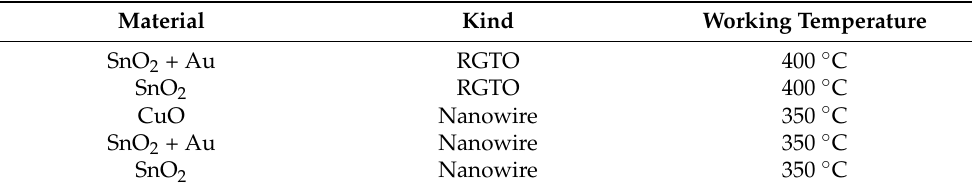
Table 2. Sensor array composition of S3 device and sensors